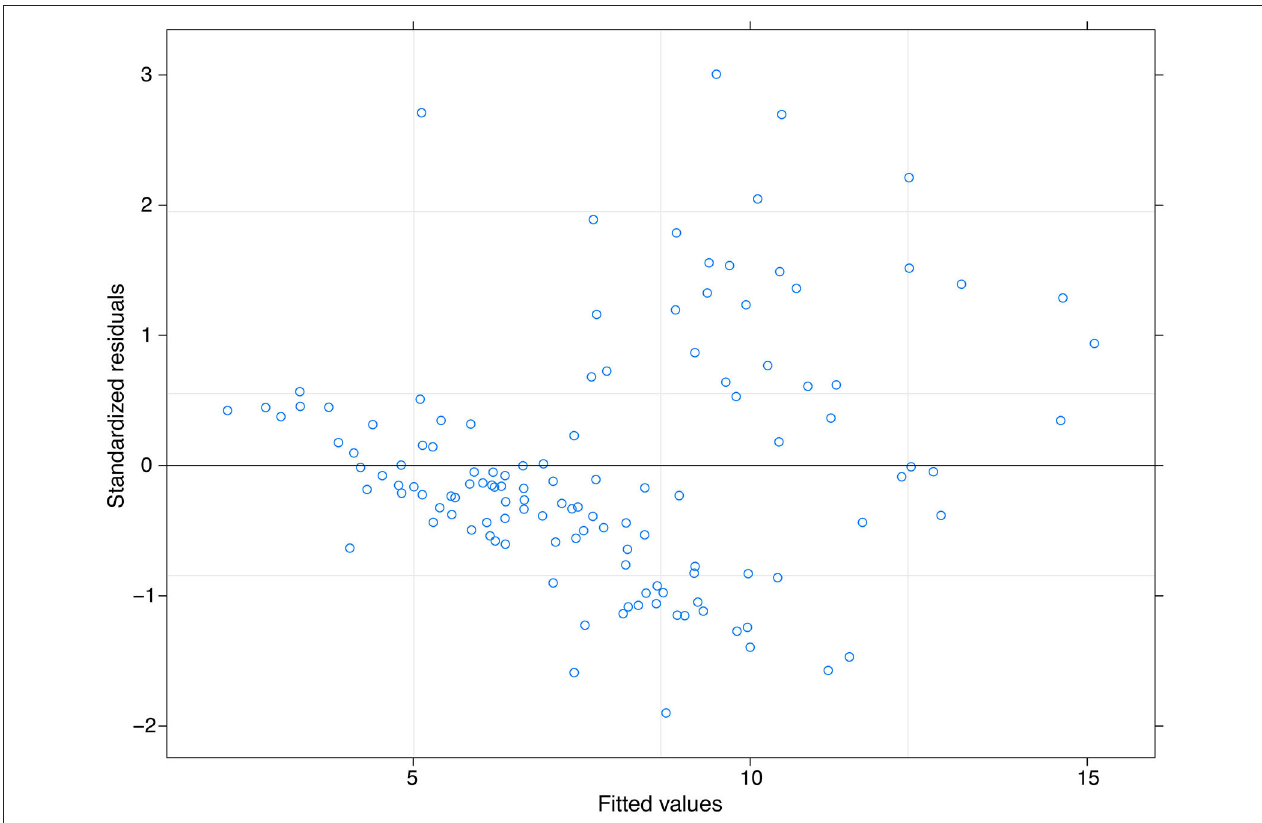
FIGURE 9 | Standardized residuals and fitted values of measured data (see Table 2 ). The residuals given above are for straight line regression via least squares, where residuals are scattered both above and below the reference line. We therefore argue the model fits the data well.